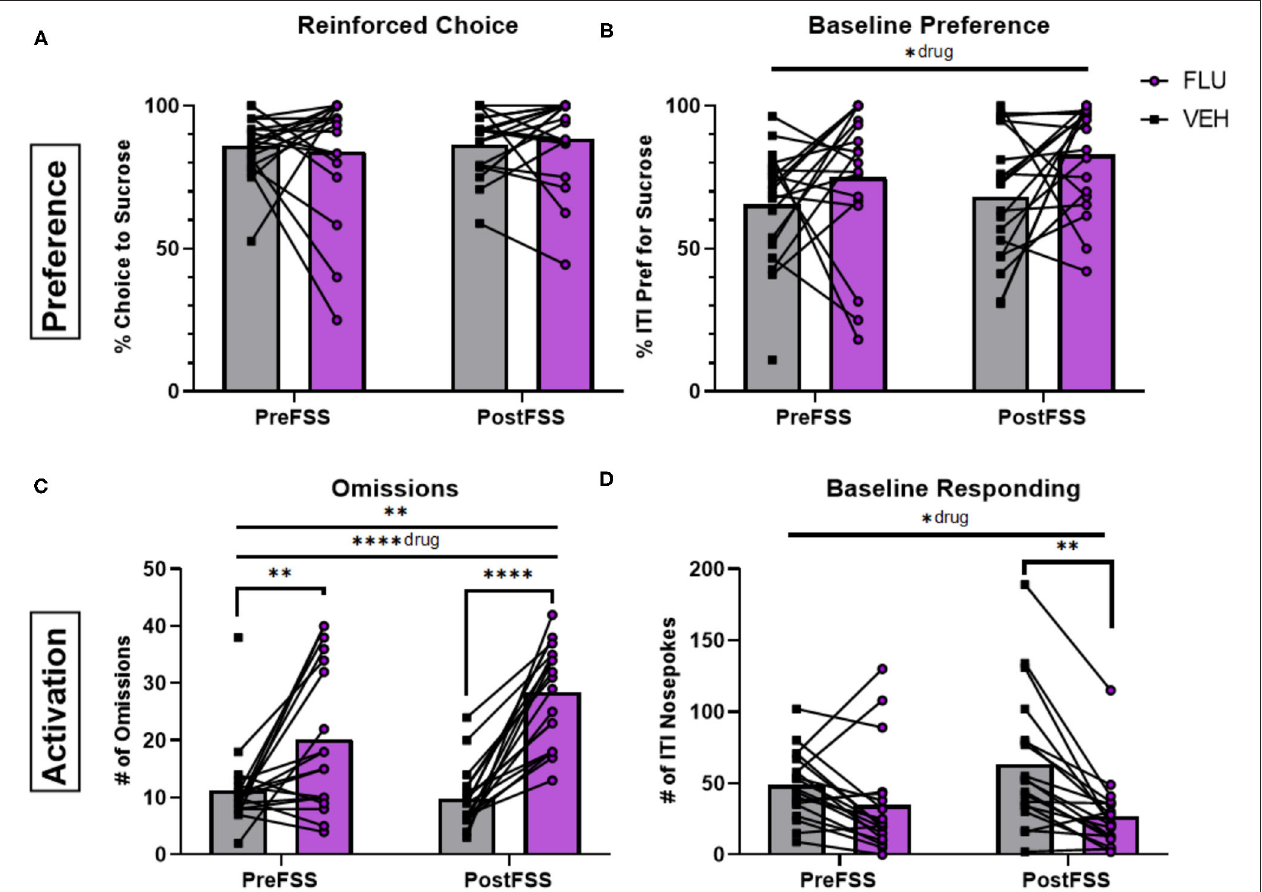
FIGURE 4 | Influence of dopamine antagonism on decision-making behaviors. (A) Averaged percentage of reinforced choice for the sucrose liquid receptacle in free-choice trials in sessions before (PreFSS) and after (PostFSS) the rFSS for animals receiving either flupenthixol (20 µ g/0.5 µ L; n = 19) or vehicle (physiological saline; n = 19). (B) Percentage of ITI nosepokes made during the session for the sucrose liquid receptacle compared to water receptacle nosepokes during the ITI. (C) Total number of omissions made during the sessions. (D) Total number of ITI nosepokes made at all during the sessions. Error bars are ( ± SEM). * P < 0.05, ** P < 0.01, **** P <